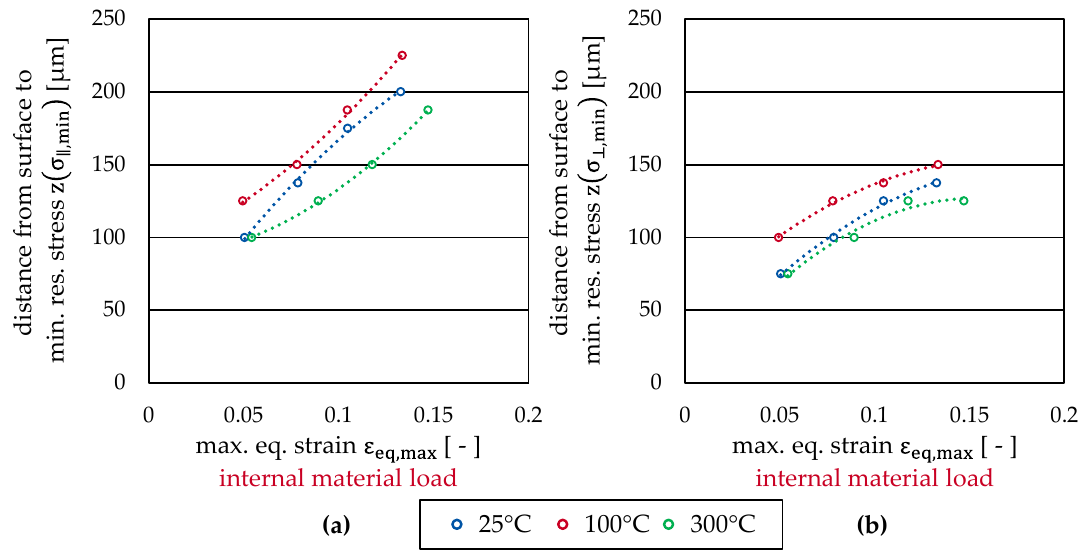
Figure 15. Simulated distances from the workpiece surface to the position where changes of the minimal residual stress components occur for different workpiece temperatures ( a ) for the minimum residual stress parallel to the rolling direction, and ( b ) for the minimum residual stress perpendicular to the rolling direction. All values derived from simulations.